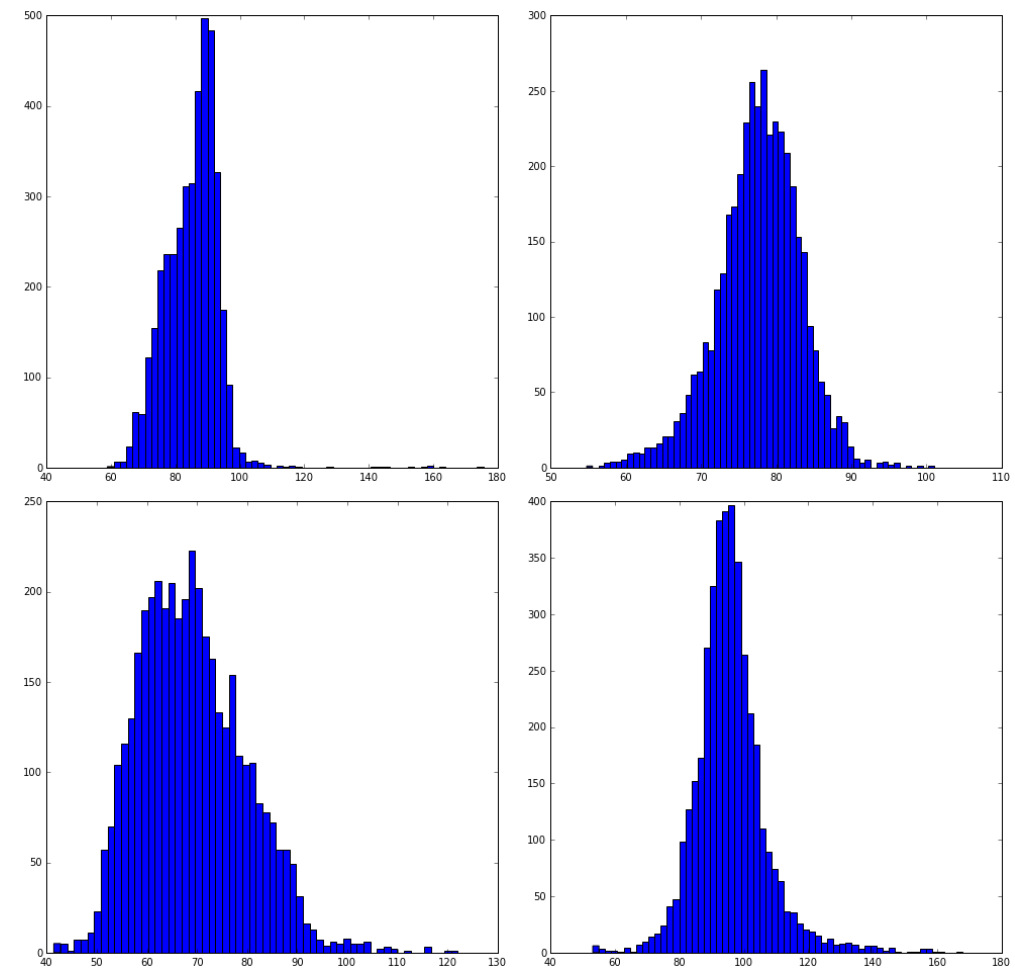
Figure 12. Histogram of the forecast RMSE ratio between the tangent space method, and a frozen map method: ( Upper left ) horizon at 30 min; ( upper right ) horizon at 1 h; ( lower left ) horizon at 3 h; and ( lower right ) horizon at 24 h. From 2016-01-10 to 2016-02-21, a total of 4080